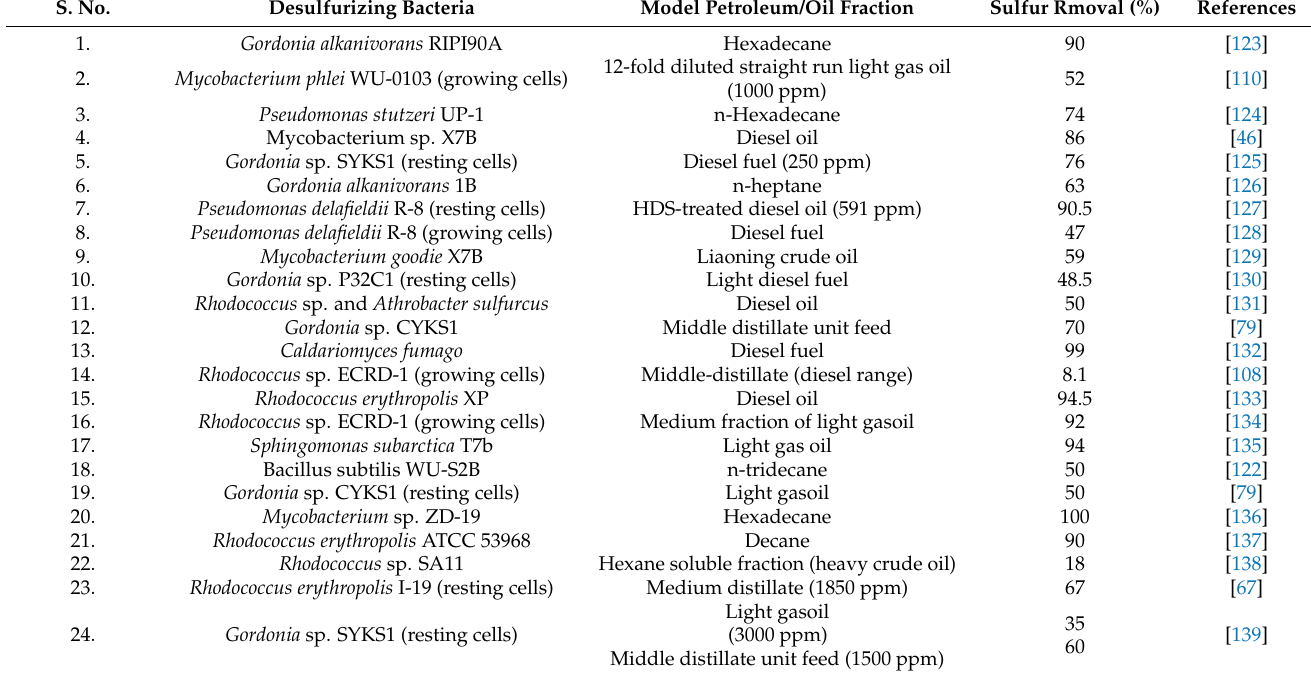
Table 3. Biodesulfurization of petroleum products by bacterial strains at optimized